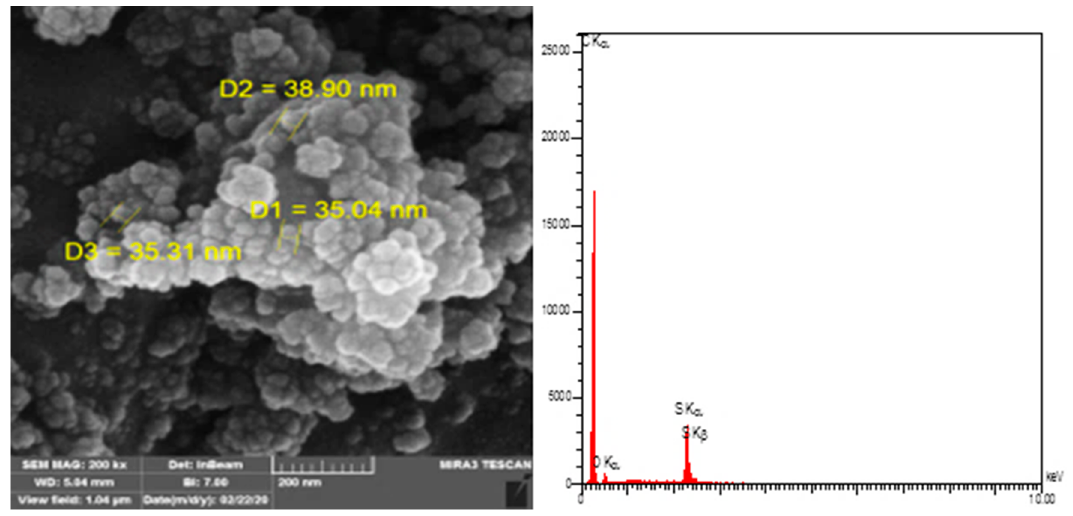
Figure 8. FE-SEM and EDX for AS-3 patch.